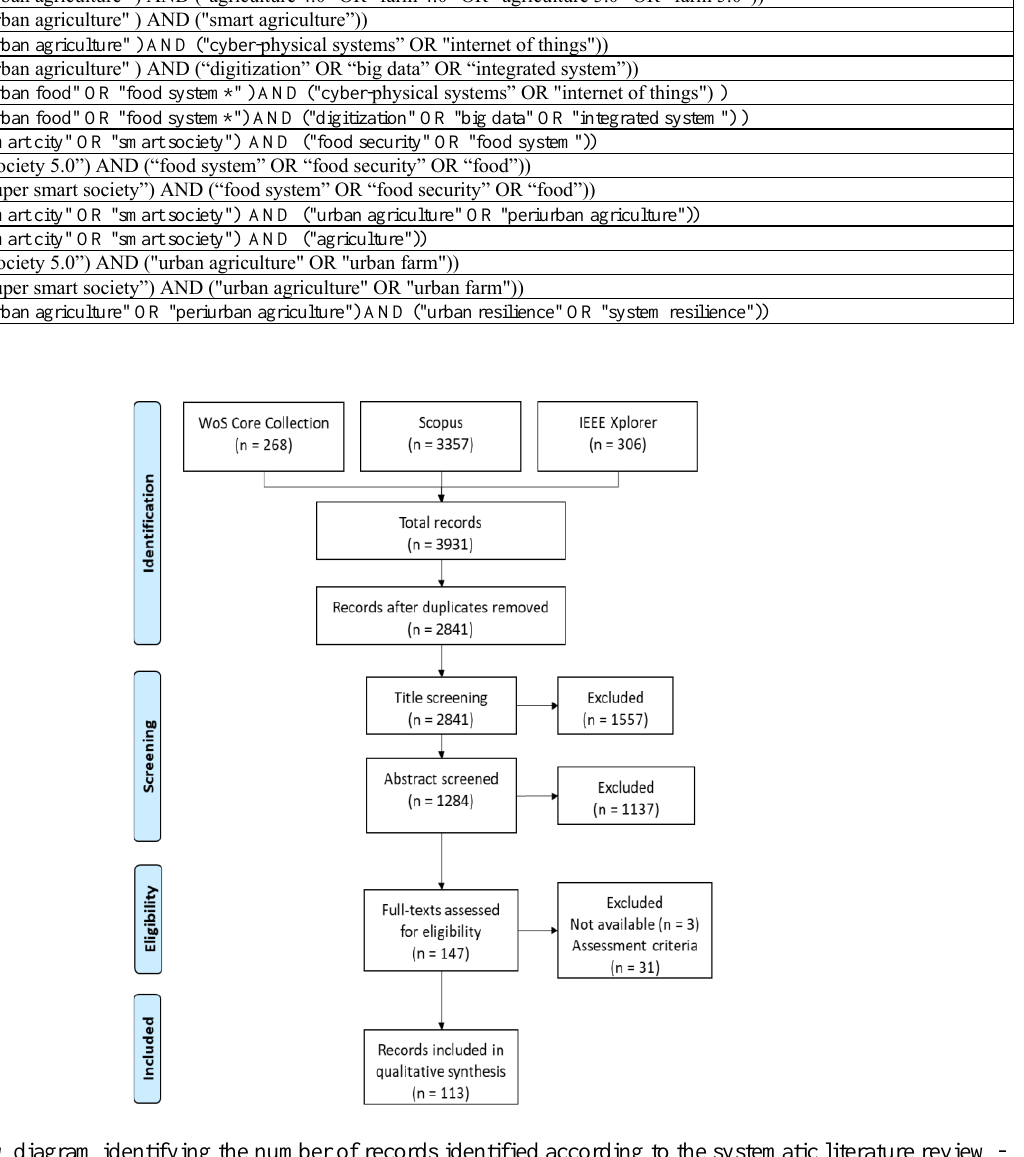
Figure 1. Flow diagram identifying the number of records identified according to the systematic literature review - PRISMA